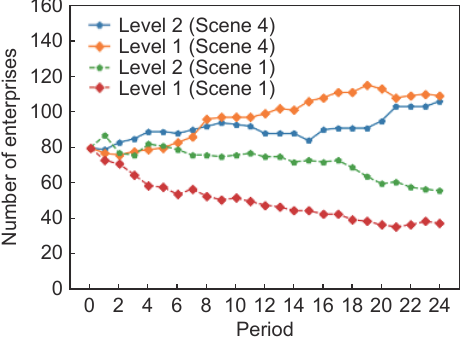
Fig. 9 Scenes 1 and 4: Changes of number of enterprises in Levels 1 and 2.